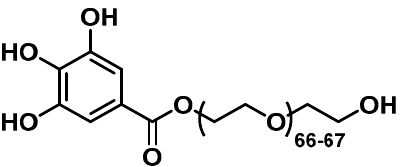
Figure 1. Chemical structure of the gallol-PEG66-67-OH ligand